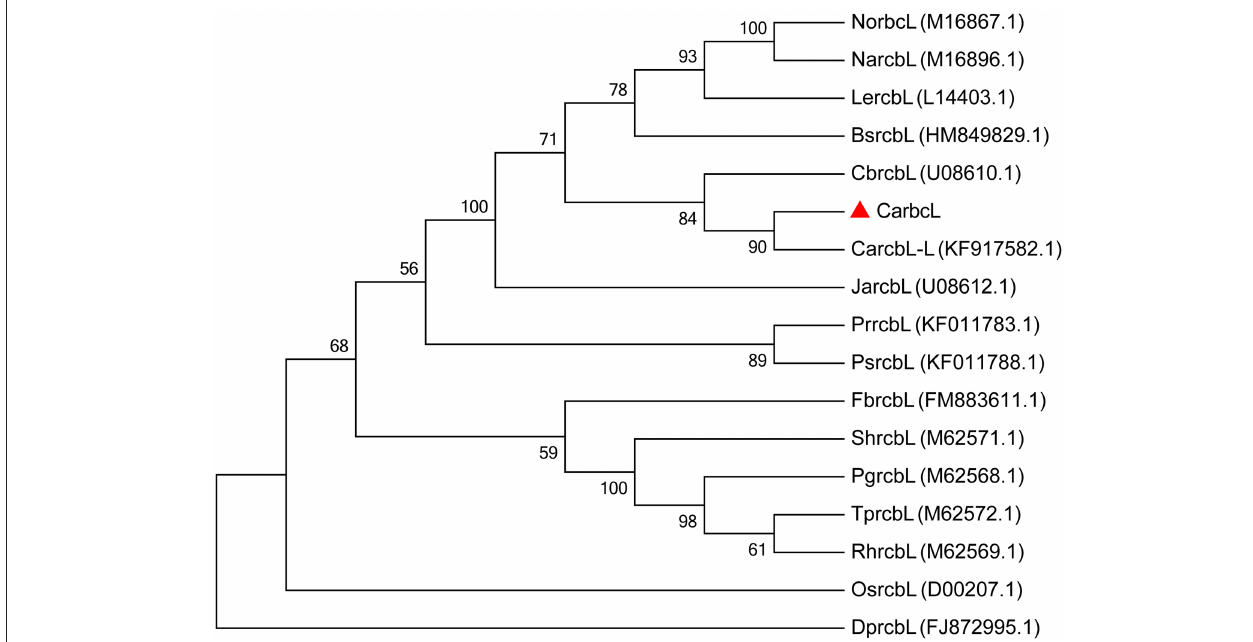
FIGURE 3 | The phylogenetic tree of CarbcL and other related sequences. Numbers below the branches are the neighbor-joining bootstrap values; CarbcL gene was marked with “ N ” symbol; GenBank accession numbers: (Tobacco) NorbcL, M16867.1; ( Lycopersicon esculentum ) LercbL, L14403.1; ( Brugmansia suaveolens ) BsrcbL, HM849829.1; ( Juanulloa aurantiaca ) JarcbL, U08612.1; ( Capsicum baccatum ) CbrcbL, U08610.1; ( Capsicum annuum ) CarcbL-L, KF917582.1; ( N. acuminata ) NarcbL, M16896.1; ( T. portulacastrum ) TprcbL, M62572.1; ( Durvillaea potatorum ) DprcbL, FJ872995.1; ( Pedicularis rex ) PrrcbL, KF011783.1;